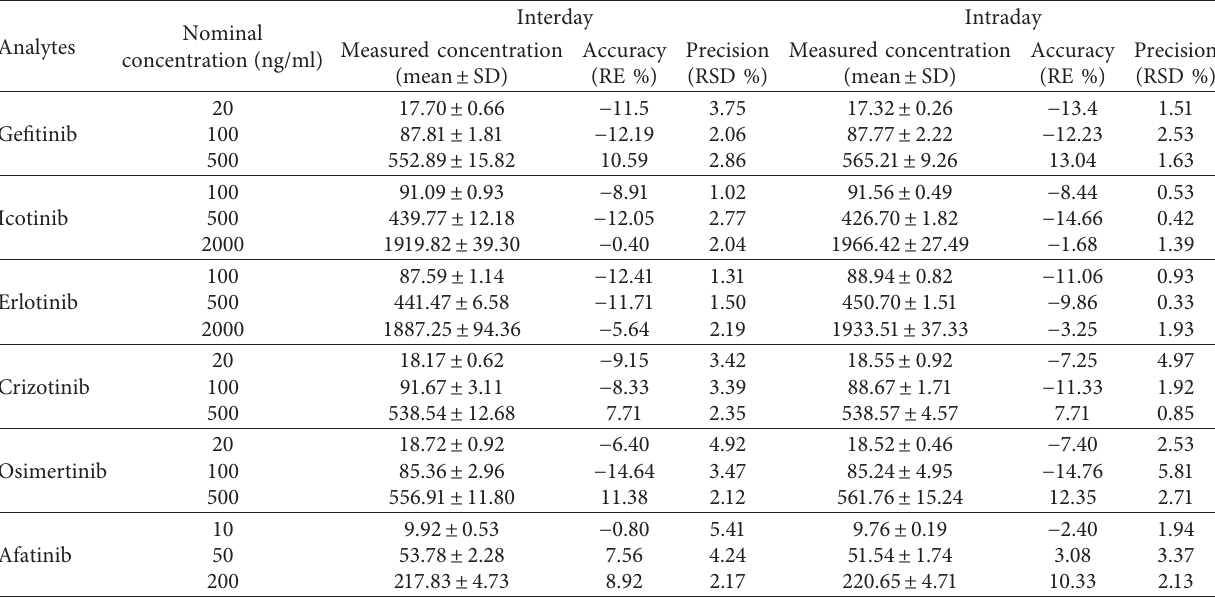
RSD was calculated using the IS-normalized matrix and recovery factors. Table 5: Inter- and intra-accuracy and precision of six analytes ( n �